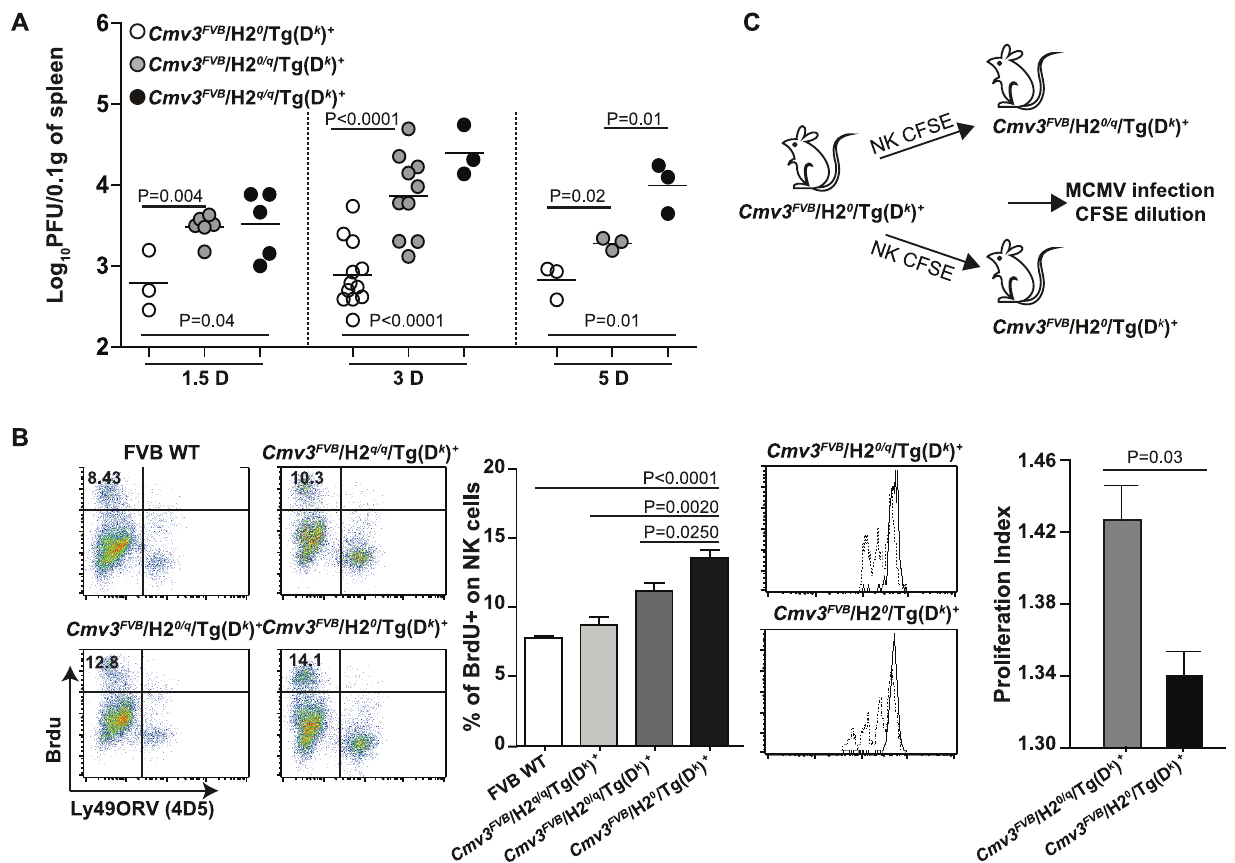
Figure 5. H2 q expression interferes with NK cell antiviral responses. (A) MCMV viral load in the spleens of F 3 transgenic mice at the indicated time-points was determined by plaque assay and P values of significant results between groups are indicated. (B) BrdU incorporation in NKp46-gated splenocytes stained with anti-BrdU and 4D5 antibodies. Splenoytes were isolated from mice of the indicated genotypes 5 days p.i. Graph bar represents the proportions of NK cells incorporating BrdU in total splenic leukocytes with standard deviations, using three mice per group. (C) Enriched NK cells from Cmv3 FVB /H2 0 /Tg(D k ) + mice were labeled with CFSE then adoptively transferred into Cmv3 FVB /H2 0 /Tg(D k ) + and Cmv3 FVB /H2 0/q / Tg(D k ) + recipients 24 hours before infection with MCMV for 5 days. Analysis of CFSE dilution in NK cells from the spleens of infected (dashed peaks) or uninfected (solid peaks) mice. NK cell proliferation index (number of divisions of CFSE-labeled NK cells) in Cmv3 FVB /H2 0 /Tg(D k ) + and Cmv3 FVB /H2 0/q / Tg(D k ) + mice. Statistically significant differences between groups are indicated. Three mice per group were analyzed and results shown are representative of two experiments. Data were analyzed using two-way ANOVA analysis and the two-tailed Student’s test. Significant P values for differences between groups are